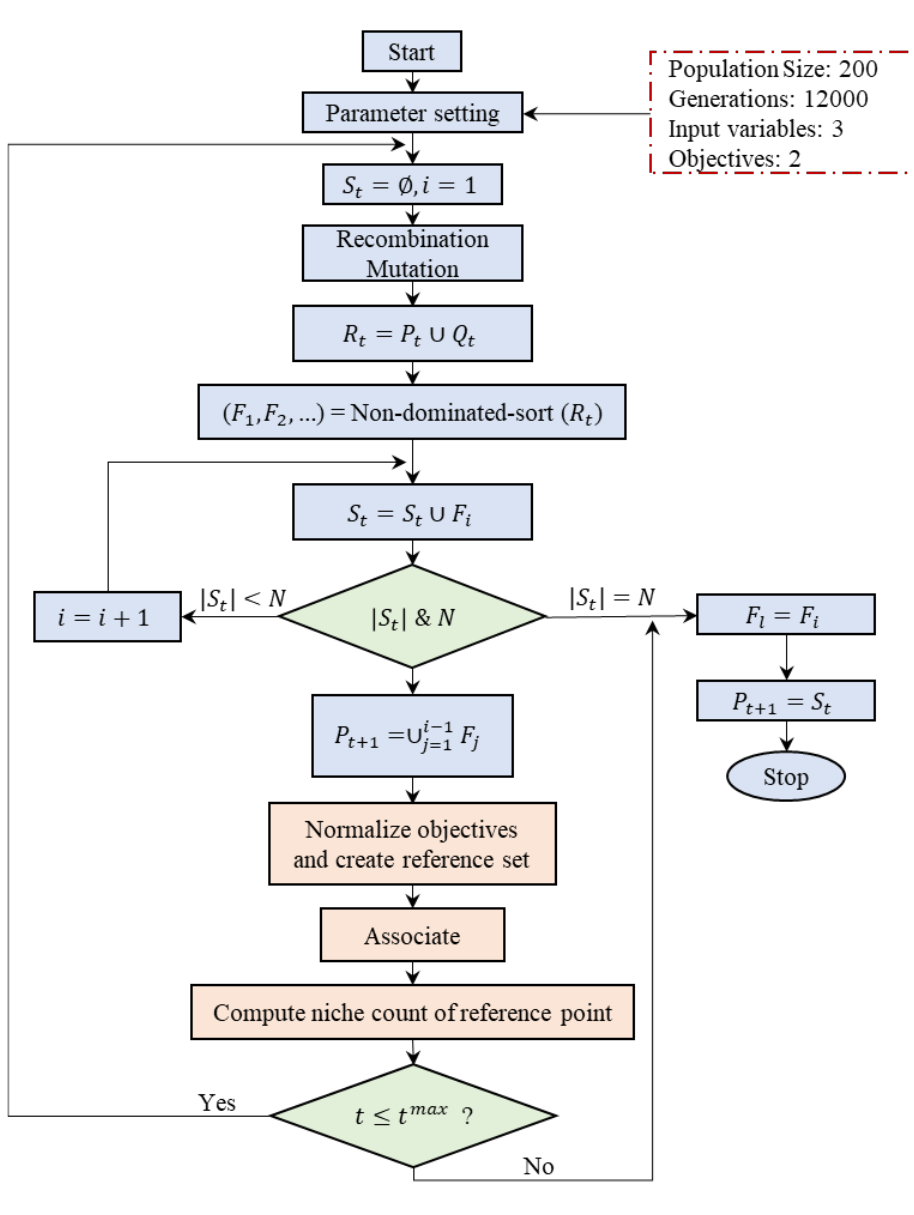
Figure 20. Flowchart of NSGA-Ш.